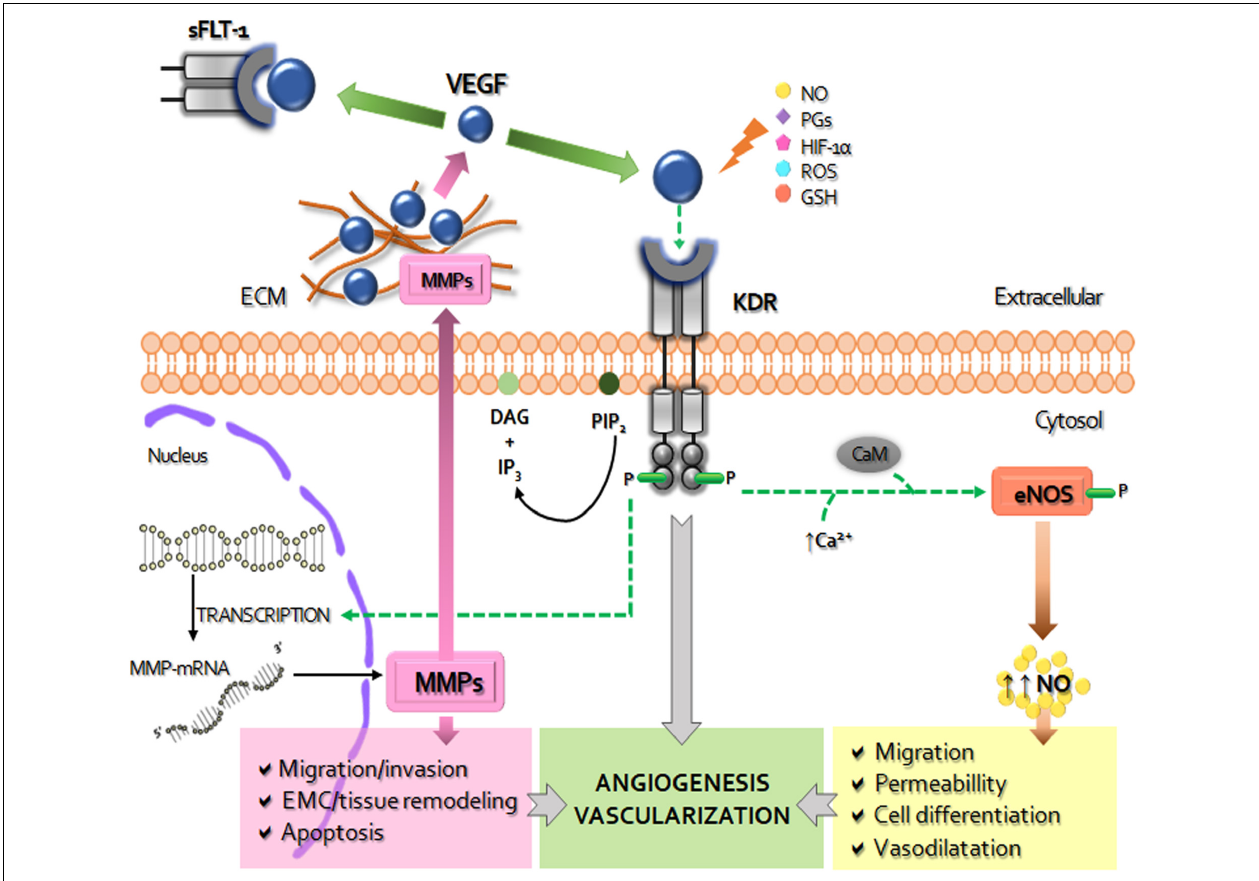
FIGURE 1 | Schematic diagram of the role of VEGF system in the placentation. The vascular endothelial growth factor (VEGF) activates the membrane kinase insert domain receptor (KDR) by phosphorylation, triggering specific signaling cascades. By increasing intracellular calcium (Ca ++ ) and calmodulin (CaM) VEGF-KDR binding induces the expression and activity of nitric oxide synthase (NOS) to produce increase of nitric oxide (NO), a strong inducer of increased vascular permeability, vasodilation, cell migration and differentiation. The other via of VEGF-KDR activation, related to fosfatidil inositol 4,5-bisfosfato (PIP-2) and diacylglycerol (DAG), leads to the transcription of metalloproteinases (MMPs). MMPs are secreted to the extracellular matrix (ECM) where, among other functions, degrade and remodel the ECM and release the ECM-sequestered VEGF by cleaving proteins that retain it in the matrix. The soluble receptor tyrosine kinase similar to fms-1 (sFLT-1) can prevent the binding of VEGF to KDR, thus decreasing it pro-angiogenic and survival activity. VEGF expression can be modified by NO, prostaglandins (PGs), hypoxia inducible factor (HIF-1 α ), reactive oxygen species (ROS), reduced glutathione (GSH), among other factors. In overall, placental activated VEGF system mediates the angiogenesis-vascularization during